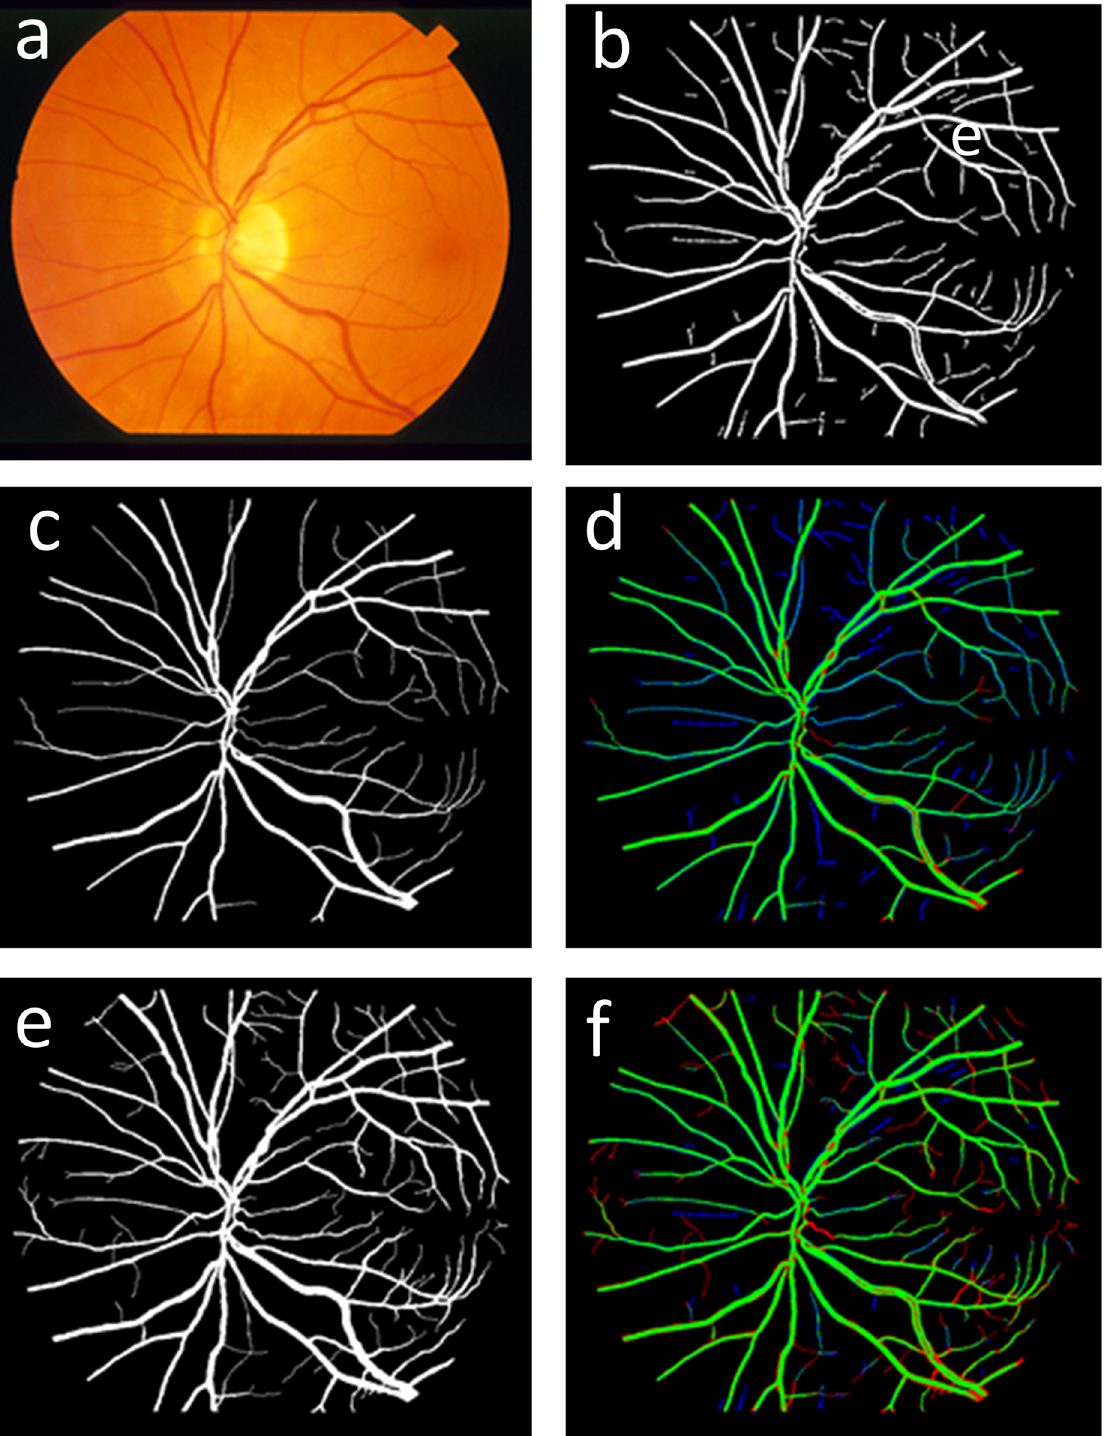
Fig 10. Overview of vessel segmentation process: (a) original RGB retinal fundus image; (b) results of the proposed vessel segment method; (c) the first manually segmented results; (d) image comparing the proposed approach with the first manually segmented results; (e) the second manually segmented results; and (f) image comparing the proposed approach with the second manually segmented